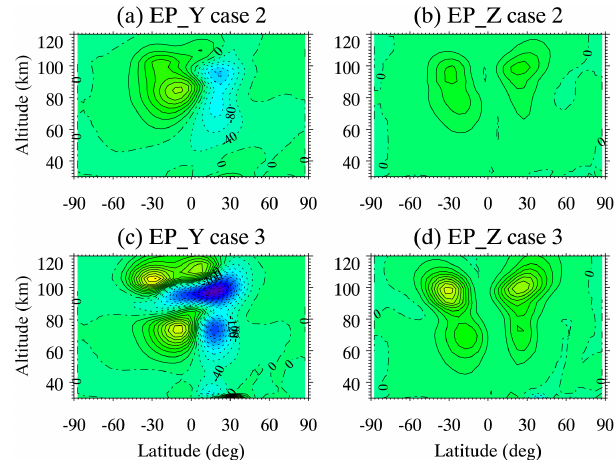
Figure 12. The same as Fig. 8 but for the W2 during model days 15–20 for (a, b) case 2 and (c, d) case